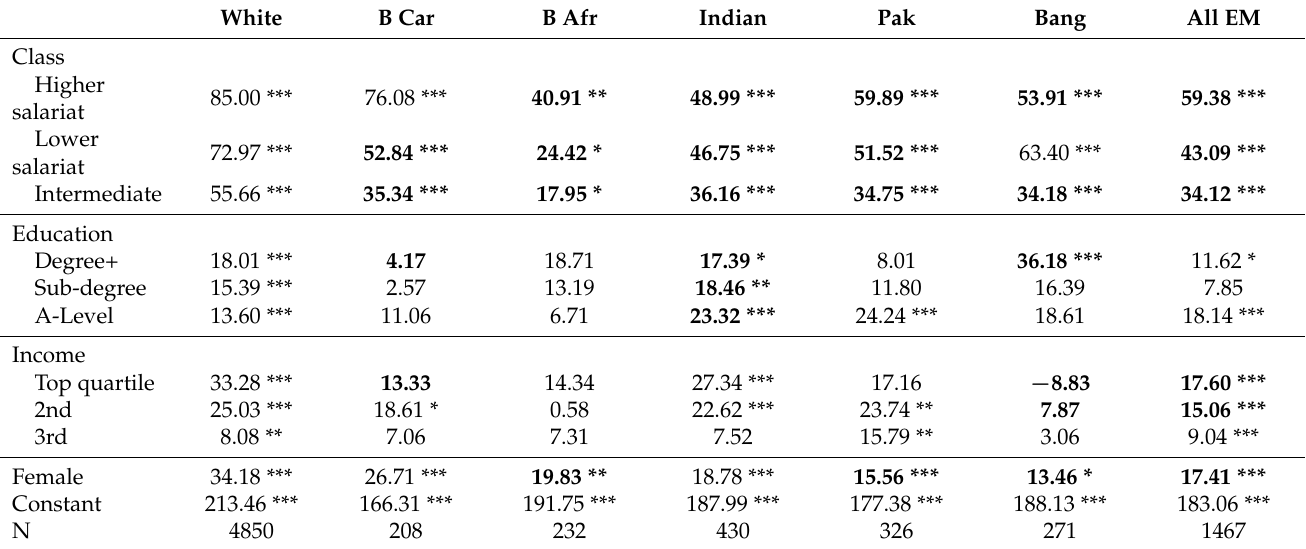
Table 9. OLS regression of weakly take-home income (GBP) by family situation and